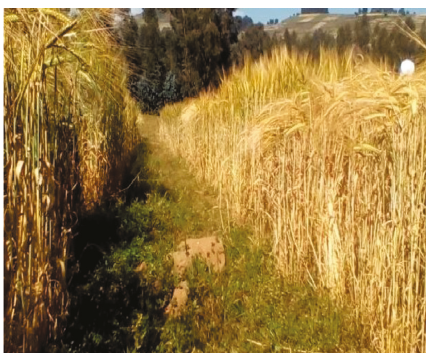
Figure 4: Field performance of malt barley varieties at Lay Gayint in 2019 cropping